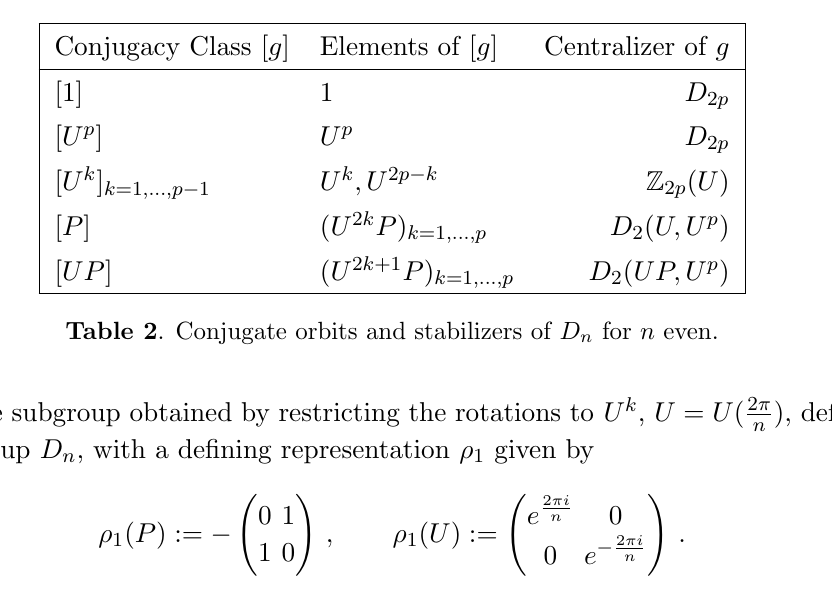
Table 1 . Conjugate orbits and stabilizers of D n for n odd.